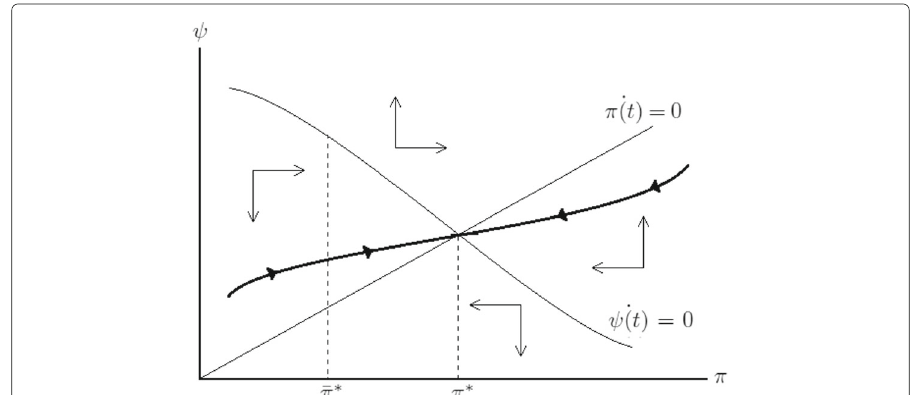
Fig. 1 Phase diagram for the dynamics of convergence towards the steady state (monotonic case)